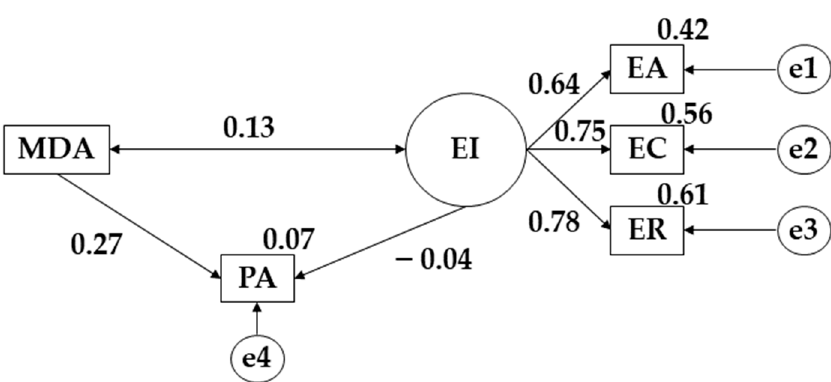
Figure 4. Model proposed for female sample. Note: physical activity (PA); Mediterranean Diet adherence (MDA); emotional clarity (EC); emotional attention (EA); emotional repair (ER). Table 3. Structural Equation Model Developed for female population.